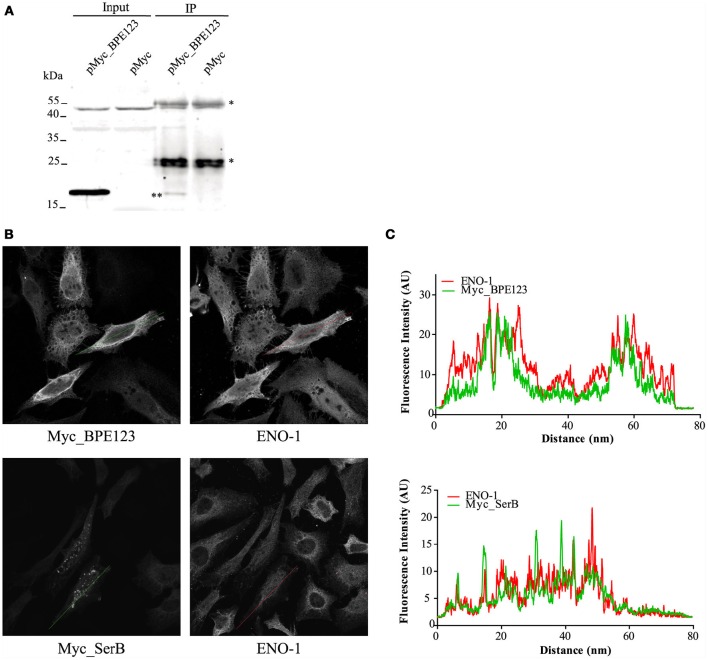
In vivo interaction between BPE123 and host ENO-1. (A) IP with anti-ENO-1 antibodies were performed with HeLa cells transfected with pMyc_BPE123 or the empty vector. The resulting IP fractions were resolved by SDS-PAGE and probed with anti-BPE123 polyclonal antibodies, showing the presence of Myc_BPE123 in the IP fraction of pMyc_PE123 transfected cells (indicated by two asterisks) but not in the IP fraction of cells transfected with the empty vector. Asterisks indicate bands corresponding to the heavy and light chains of immunoglobulin. (B) Representative confocal micrographs showing ENO-1 distribution in HeLa cells transiently transfected for 24 h with a plasmid expressing Myc_BPE123 or Myc_SerB included as control. Transfected cells grown on coverslips were stained with anti-ENO-1 and with anti-Myc antibody to visualize BPE123 or SerB. (C) Fluorescence intensity profiles (arbitrary units) across the traced lines are shown for Myc_BPE123 or Myc_SerB (green) and ENO-1 (red).